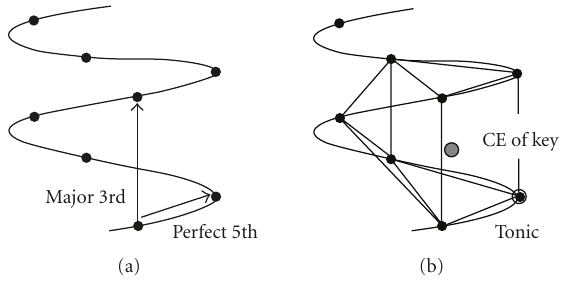
Figure 2: (a) Pitch spiral in the spiral array model, and (b) the gen- erating of a CE to represent the